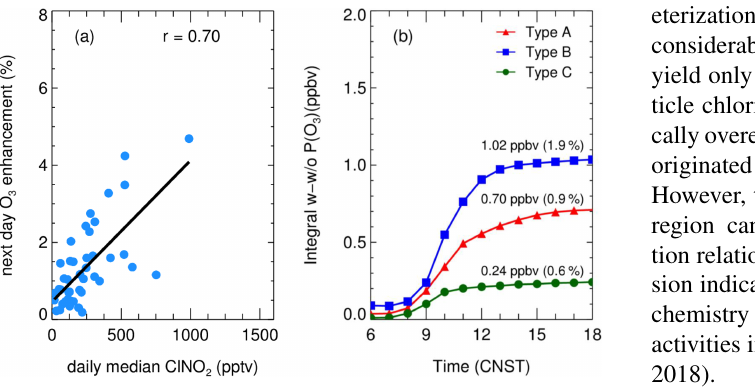
Figure 11. (a) The correlation of daily median ClNO 2 (18:00– 06:00) and its impact on next-day net O 3 production enhancement during the campaign; (b) the average contribution of daytime inte- gral O 3 by ClNO 2 mechanism in the three types of air